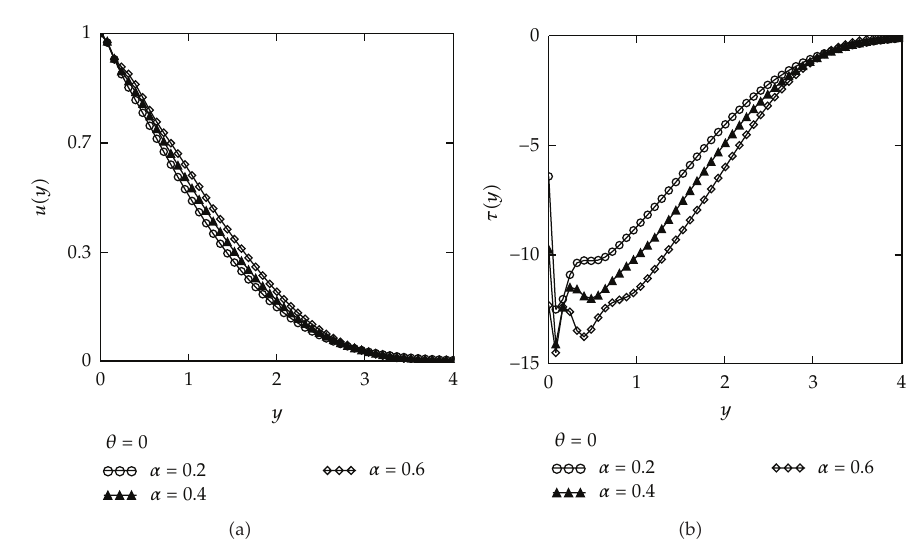
Figure 8: Profiles of the velocity field u (cid:4) y,t (cid:5) and the shear stress τ (cid:4) y,t (cid:5) for fractional Maxwell fluid given by (cid:4) 5.3 (cid:5) and (cid:4) 5.4 (cid:5) , for U (cid:9) 1, y (cid:9) 1, ν (cid:9) 0 . 379, μ (cid:9) 33, λ (cid:9) 1 . 5, θ (cid:9) 0 . 0, t (cid:9) 5s, and di ff erent values of α .